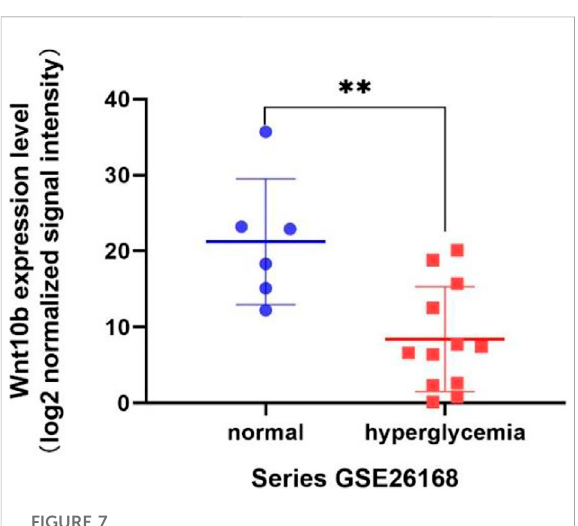
FIGURE 7 Wnt10b expression level from the GEO data sets